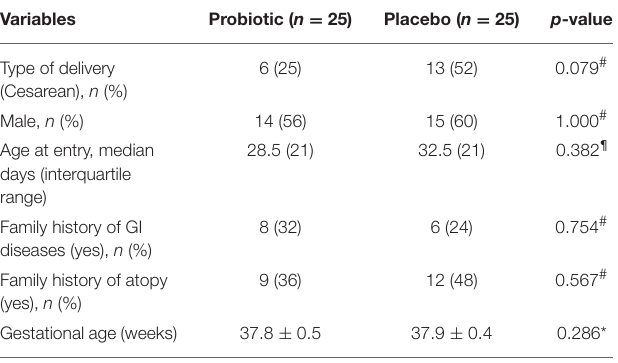
TABLE 1 | Baseline characteristics of the participants in the two study groups. Variables